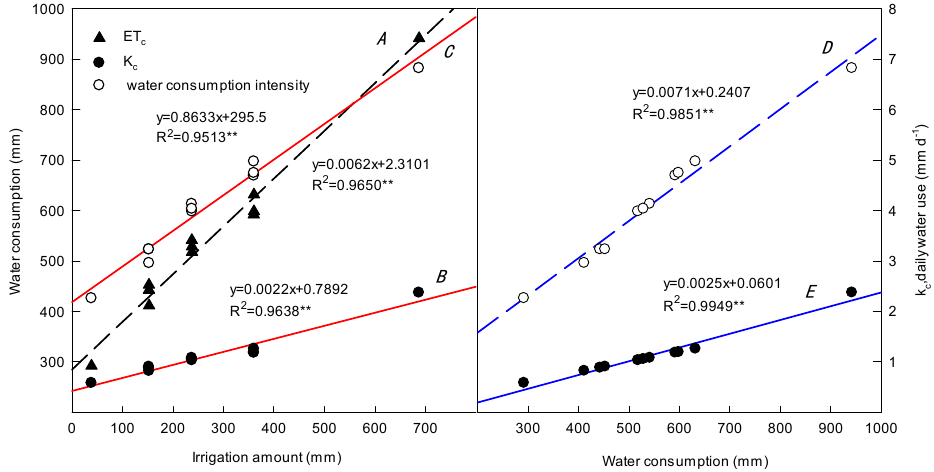
Figure 9. The relationships between irrigation water and water use characteristics. A , B , and C denote changes of ET c , k c , and daily water use with irrigation water. D and E denote changes of daily water use and k c with irrigation water.